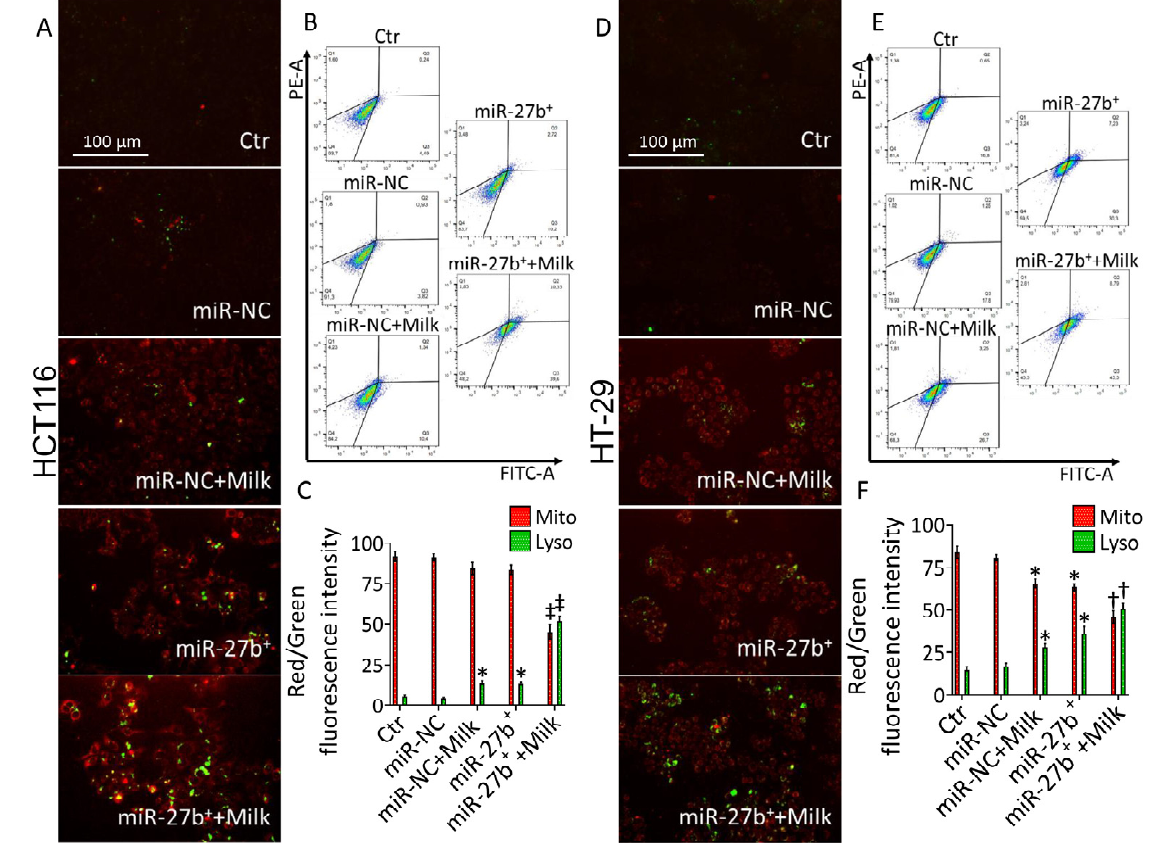
Figure 5. MiR-27b + +Milk increased lysosome accumulation. Representative fluorescent images of mitophagy (red) and lysosome (green) dyes and FACS analysis, reported as fluorescence intensity, in ( A – C ) HCT116 and ( D – F ) HT-29 cells transfected with 30 nM mimic Negative Control (miR-NC) and miR-27b mimic (miR-27b + ) or with miR-NC and miR-27b + before 72 h with 40% v / v milk treatment (miR-NC + Milk and miR-27b + +Milk). Control cells (Ctr) were treated with the highest volume of HBSS-10 mM Hepes. Scale bars = 100 µ m. * p < 0.05 vs. miR-NC; † p < 0.05 vs. miR-27b + ; ‡ p < 0.01 vs. miR-27b + .